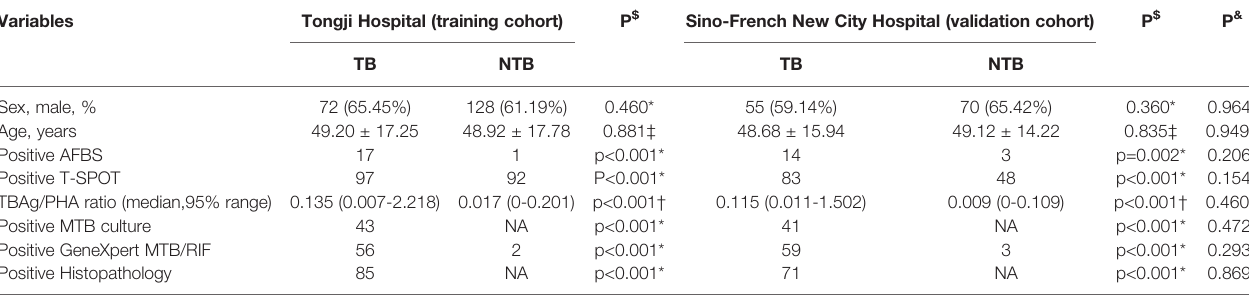
TABLE 1 | The clinical and demographic characteristics of recruited patients in two independent